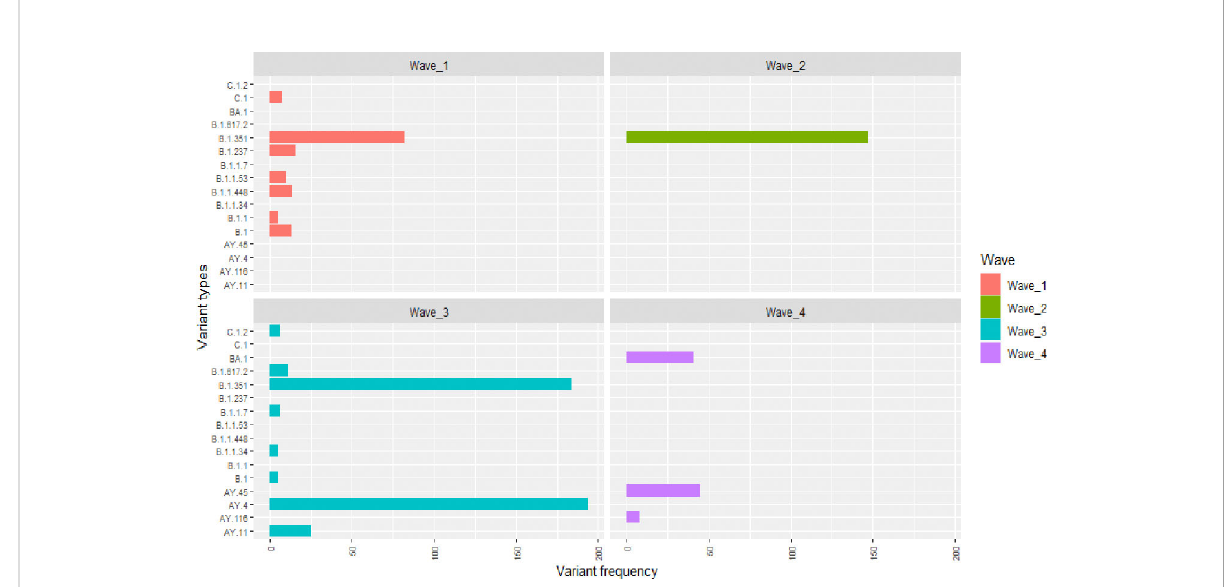
FIGURE 1 The SARS-CoV-2 variants and their frequency in Free State during the course of four epidemic waves based on genomic surveillance data analysed between July 2020 and December 2021. The y-axis indicates the SARS-CoV-2 variants while the x-axis shows the occurrence frequency. The fi rst, second, third and fourth waves are denoted by the red, green, blue and purple colours, respectively. Unique variants that were identi fi ed in each wave are summarized in Table